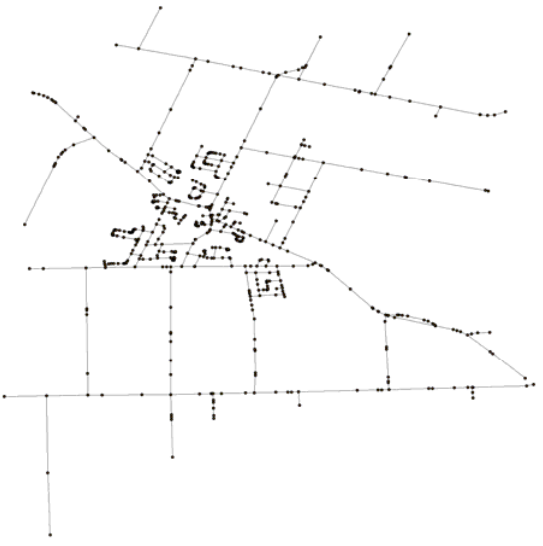
Figure 2. The converted ‘ igraph ’ graph with all geometric properties retained (Ontario road data).